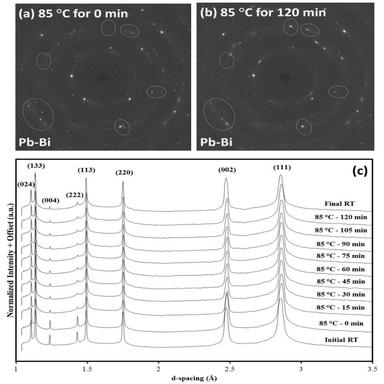
Full Debye-Scherrer rings of the Pb-Bi foil at 85 ◦C at (a) 0 and (b) 120 min. Some textural changes that occurred in the foil during the temperature hold are highlighted by ellipses. (c) Integrated 1-D diffraction patterns from a Pb-Bi foil during isothermal holding at 85 ◦C, where only patterns at every 15 min interval are shown.